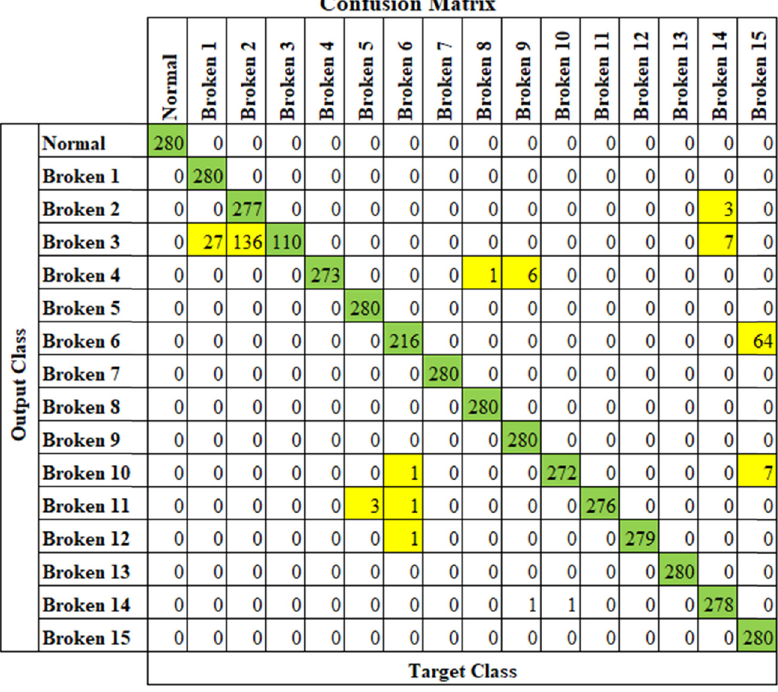
Figure 14: Confusion Matrix for worst performance model.